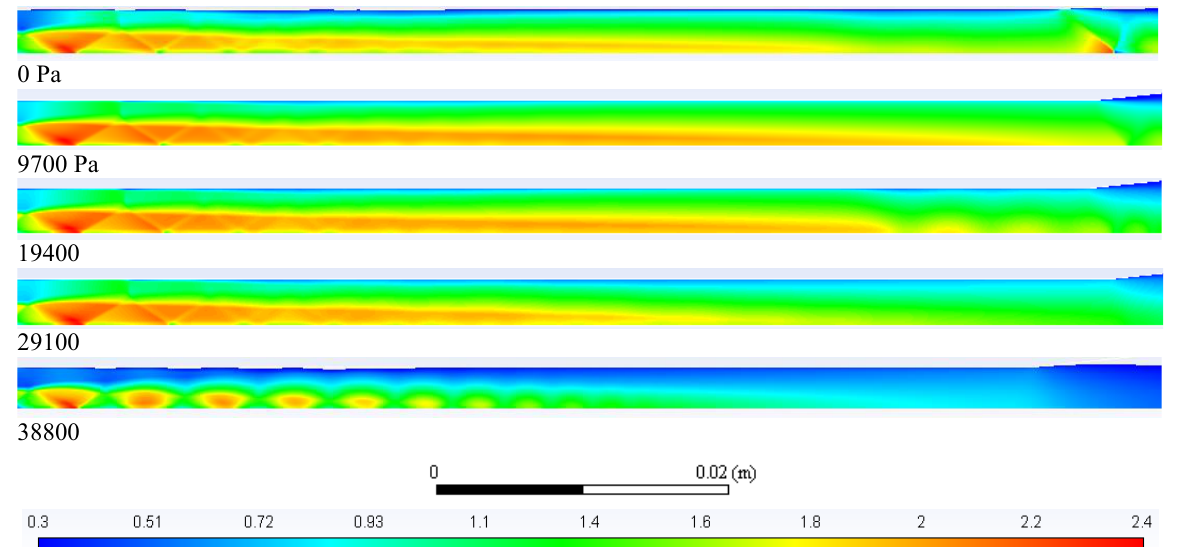
Fig. 3. :Contours of Mach number at different pressure ratio